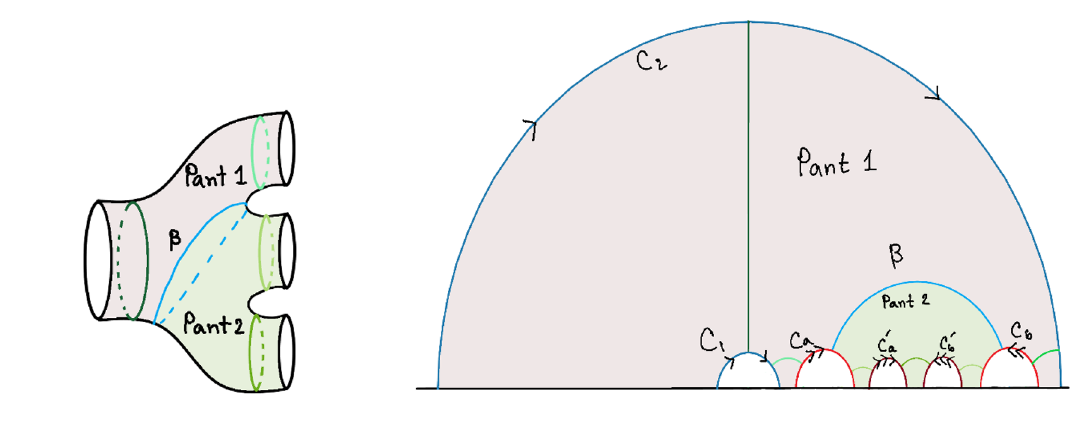
Figure 3. Four boundary case in upper half space